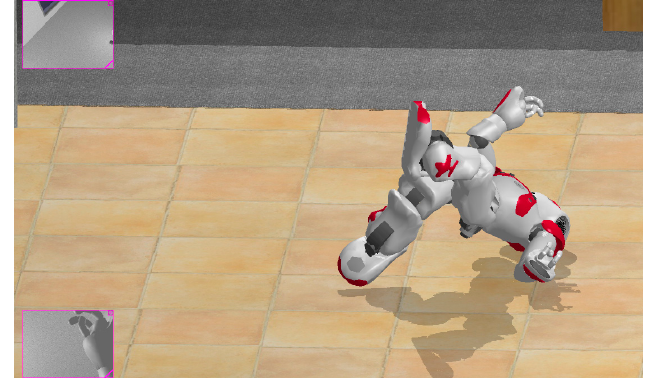
Figure 14. NAO trying to stand up and failing.